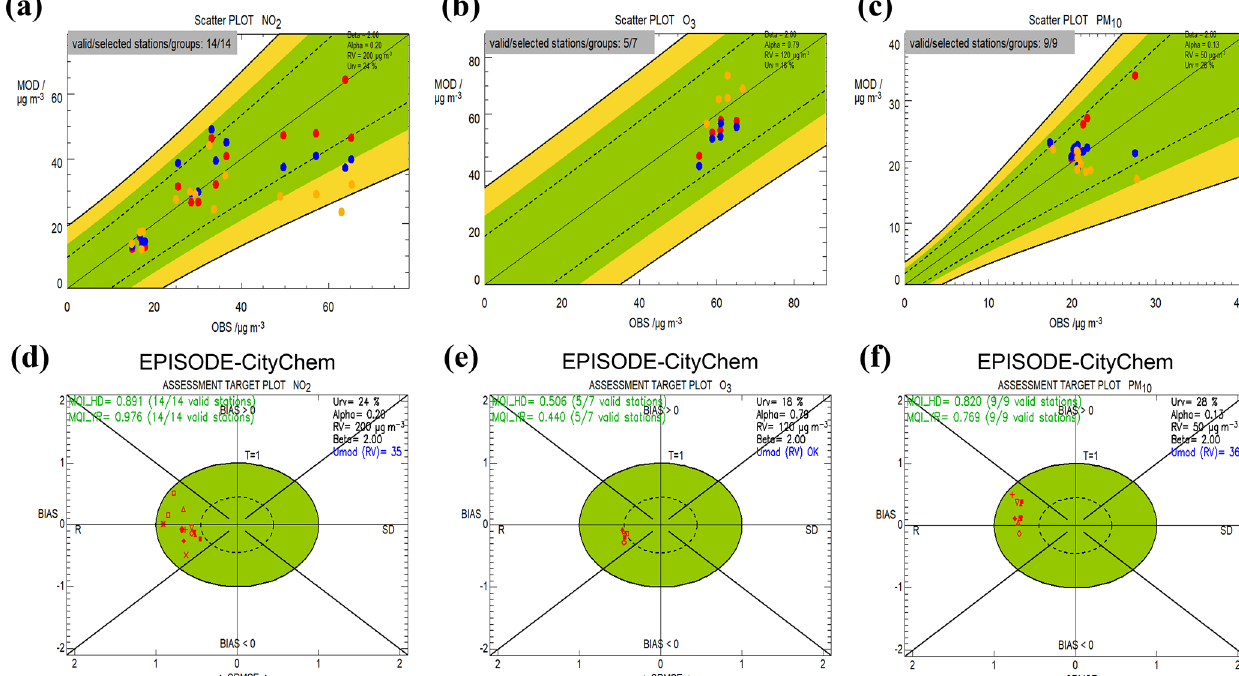
Figure 8. Model performance evaluation for monitoring stations in the Hamburg AQ network: (a) scatter diagram for NO 2 hourly values, (b) scatter diagram for O 3 daily max. of 8h running mean, (c) scatter diagram for PM 10 daily values, (d) target plot for NO 2 hourly values, (e) target plot for O 3 daily max. of 8h running mean and (f) target plot for PM 10 daily values. Scatter diagrams show model data from EPISODE–CityChem (red dots), standard EPISODE (blue dots) and TAPM (orange dots). In the scatter diagrams, the uncertainty parameters ( β , α , RV, u RV r ) used to produce the diagram are listed on the top right-hand side; dashed and solid lines indicate NMB / 2RMS U ratios of 0.5 and 1. Target diagrams show the evaluation of EPISODE–CityChem. The target diagrams indicate MQI (MQI HD for hourly and daily values, MQI YR for yearly average) for the station most distant from the origin and the model uncertainty,